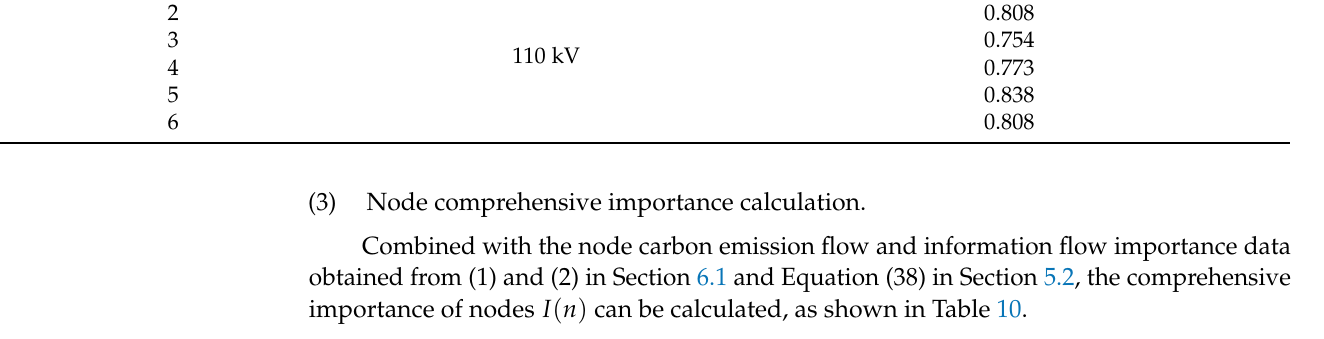
Table 10. Comprehensive node importance